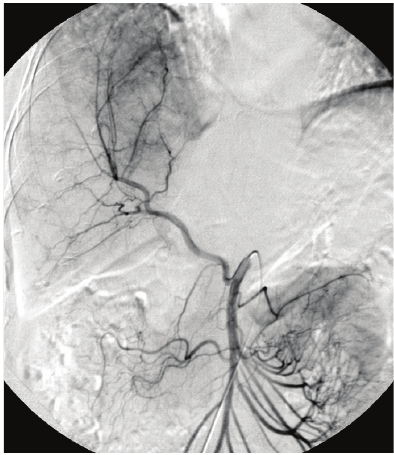
Figure 1: A selective angiogram of the superior mesenteric artery reveals the replaced right hepatic artery. Tumor-associated hypervascularity in the liver is